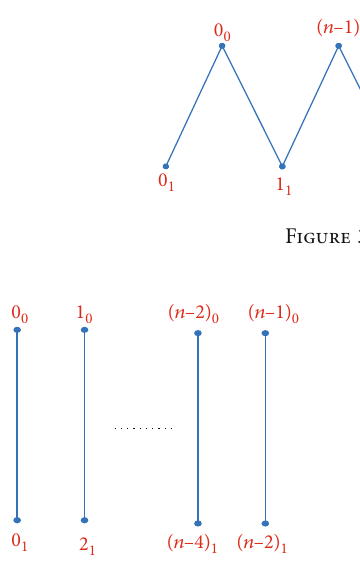
Figure 4: An orthogonal labeling for nK